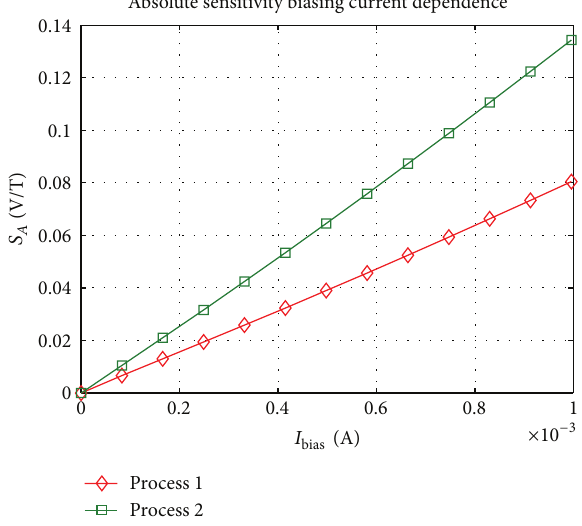
Figure 9: The simulated absolute sensitivity 𝑆 𝐴 versus the biasing current for two integration CMOS processes.